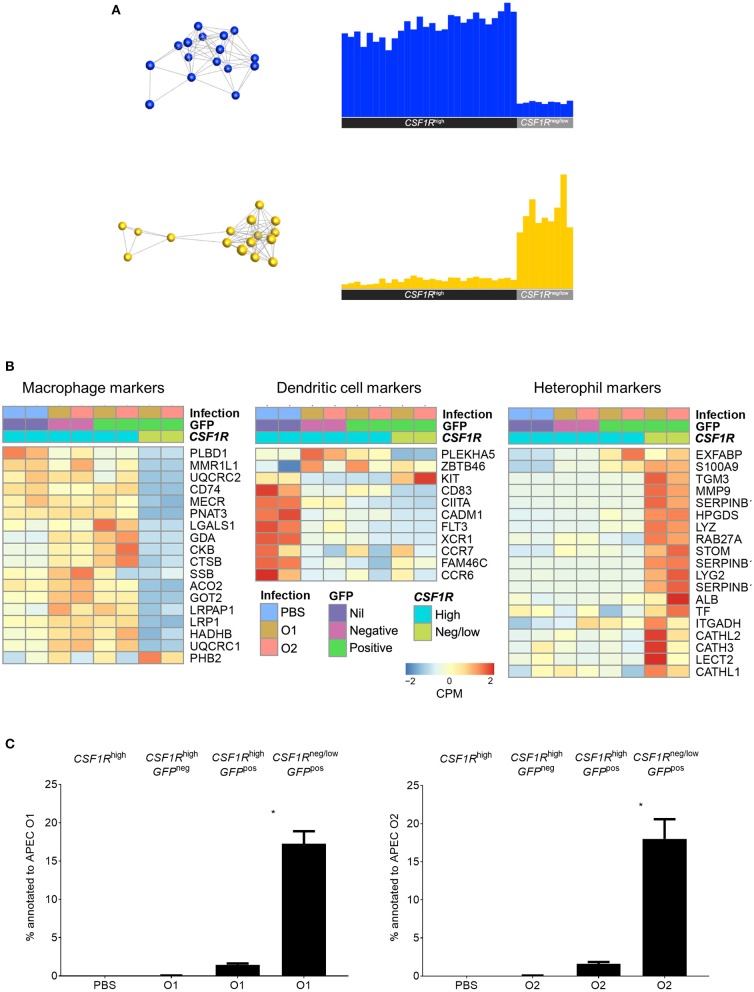
Transcriptome analysis of sorted lung cells from uninfected and APEC infected birds. (A) Network graph of macrophage (blue) and heterophil (yellow) marker expression with the corresponding graph of the average expression of the markers across all samples. This macrophage and heterophil related genes each formed single clusters that showed high expression in the CSF1R-tghigh and CSF1R-tgneg/low samples, respectively. (B) Heatmaps of normalized expression of macrophage, DC and heterophil related genes cross the sorted cells post-infection. Heatmap coloring is based on counts per million with red indicating high counts and blue indicating low counts. (C) Annotation of the obtained reads of APEC O1 or APEC O2 genome from the RNA-seq data from the sorted cells showing a significantly higher percentage of bacterial reads in the APECpos
CSF1R-tgneg/low cells as compared to the APECpos
CSF1R-tghigh cells, and no difference between the APEC strains. The mean with SEM is shown. *P < 0.05.